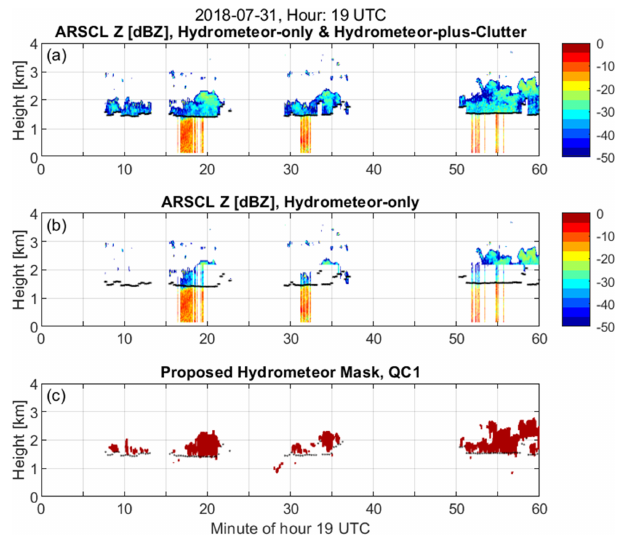
Figure 1. Active Remote Sensing of CLouds product (ARSCL) for hour 19:00UTC (14:00LT) from the DOE ARM Southern Great Plains (SGP) central facility on 31 July 2018. (a) ARSCL reflec- tivity for radar volumes ARSCL classified as either hydrometeor- only or hydrometeor-plus-clutter. (b) ARSCL reflectivity for radar volumes ARSCL classified as hydrometeor-only. (c) Hydrometeor mask produced using the method described herein. The black sym- bols in all panels are ceilometer-derived cloud base. Note the hy- drometeor misclassification below the ceilometer cloud base in (b) motivates the need for improved insect clutter